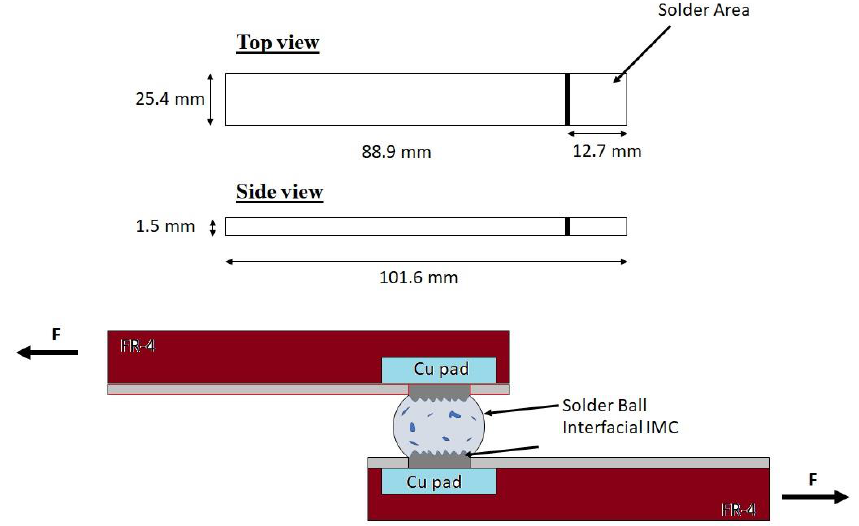
Figure 3. Illustration of the shear test of solder joints.